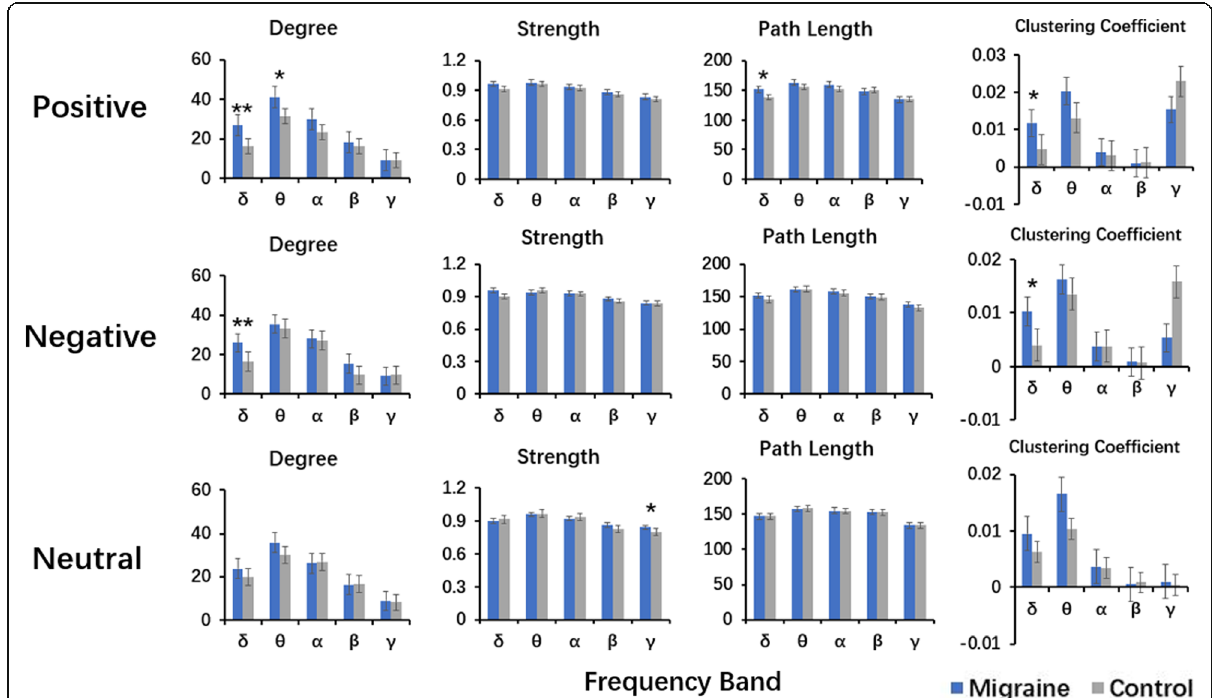
Fig. 5 Comparison of the organization of the EC networks measured by four parameters (degree, strength, path length, and clustering coefficient) between the migraine patients and healthy controls. *p represents P < 0.05 before correction for multiple comparisons, **p represents P < 0.05 and the result was still significant after correction for multiple comparisons using the FDR controlling procedure (corrected for 5 × 4 tests) with FDR = pFDR * i/N. Here, pFDR= 0.05 (usual significance value in most statistical tests), i refers to the ranked index of the p -values that